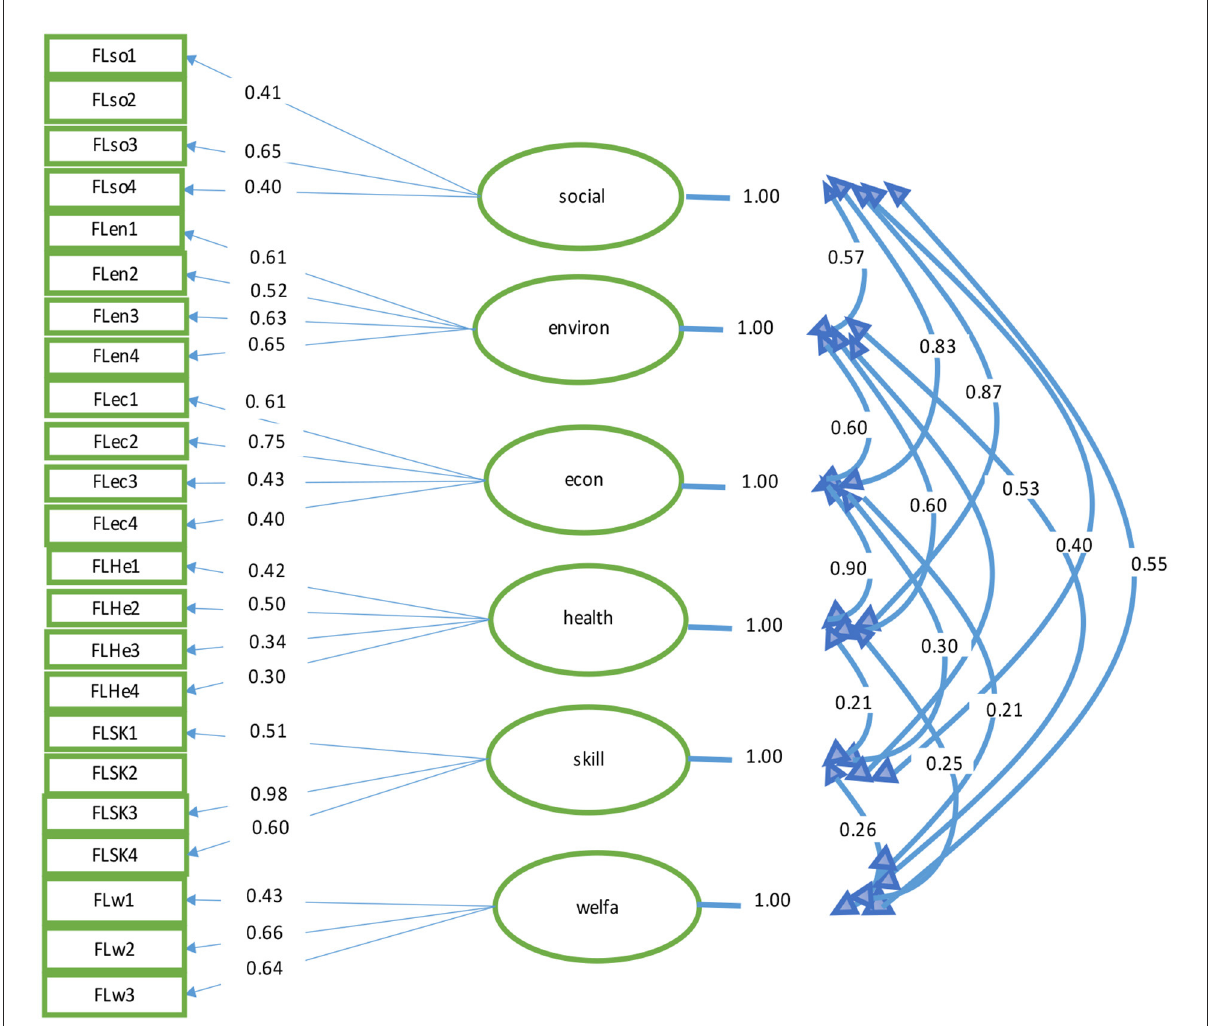
FIGURE2 Estimate